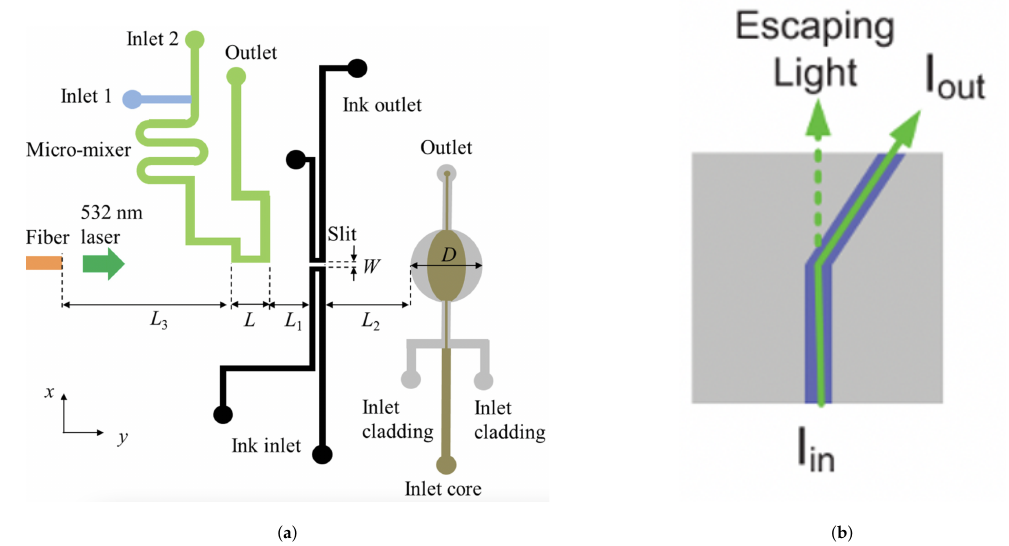
Figure 26. ( a ) PDMS based optical slit system. Reprinted with permission from [151] © (2019) The Optical Society. ( b ) Bent waveguide structures using SU-8. Reprinted with permission from [152] © (2018) The Optical